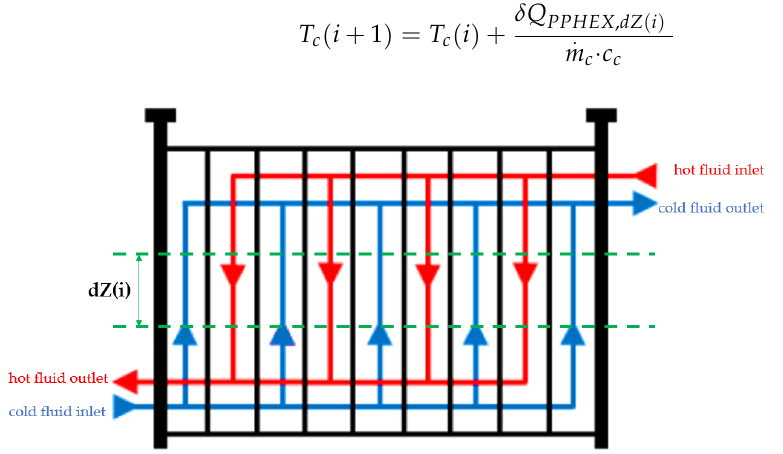
Figure 2. Plate heat exchanger height discretization.